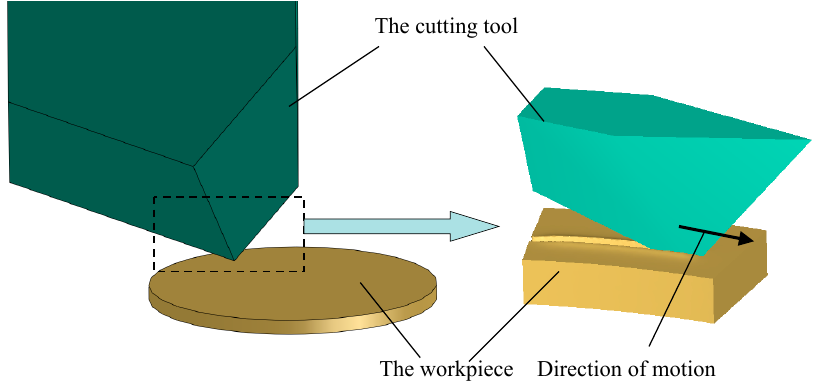
Figure 7. Geometry model of the workpiece and the cutting tool in simulation.